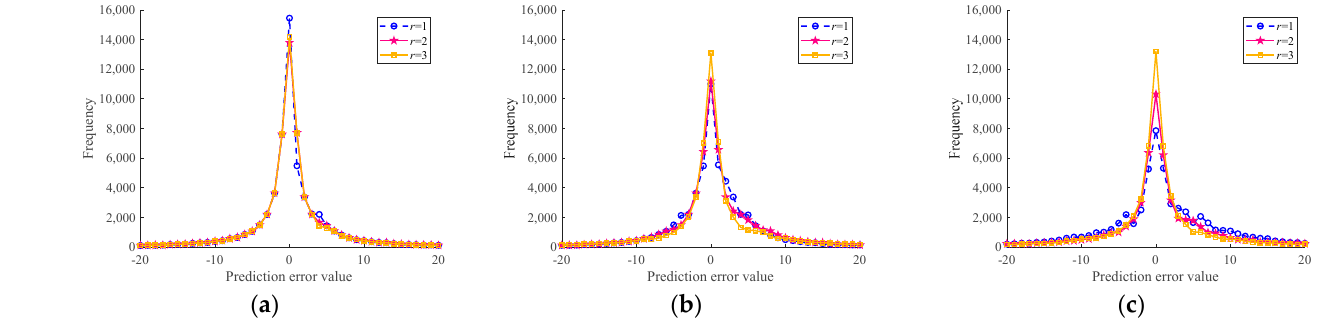
Figure 9. The prediction error distributions for Lena at r = 1, 2, 3: ( a ) under 0.1 bpp; ( b ) under 0.4 bpp; and ( c ) under 0.7 bpp.